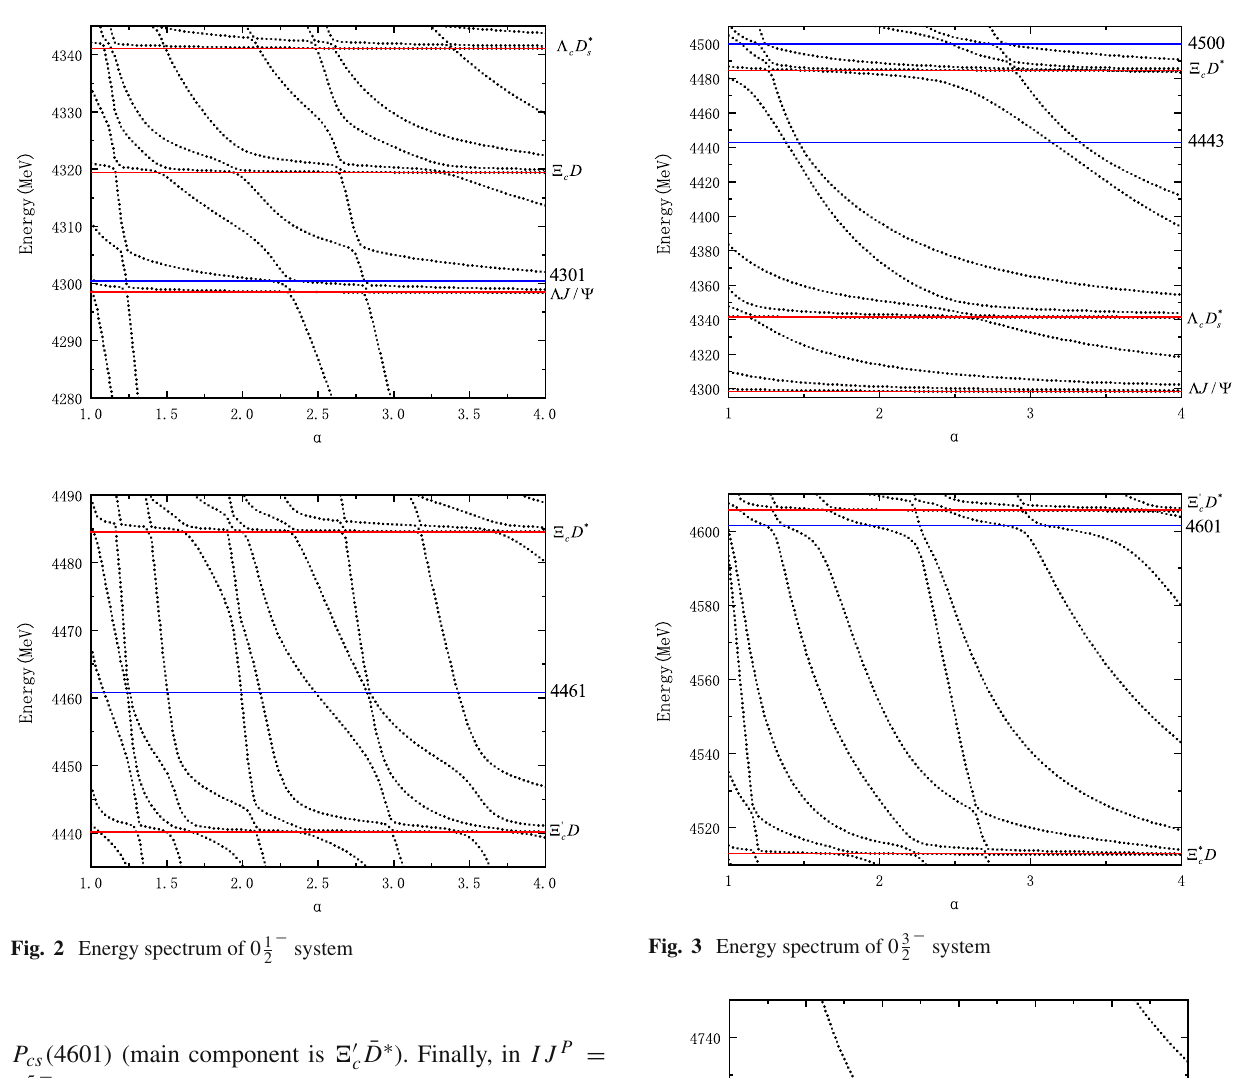
− system Fig. 3 Energy spectrum of 0 3 2 2